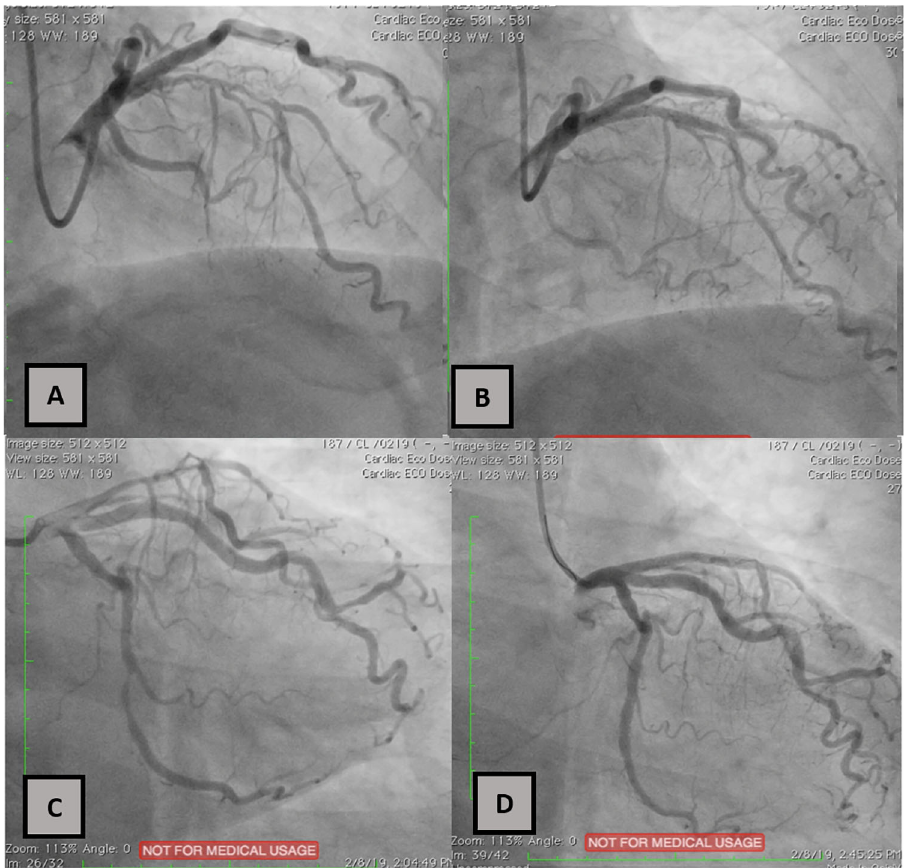
Figure 1. Percutaneous coronary intervention was performed at the left anterior descending (LAD) artery (A: before; B: after) and the left circumflex (LCx) artery (C: before; D: